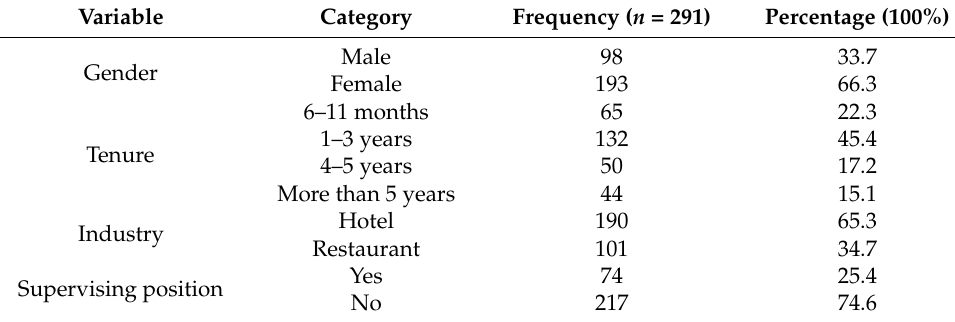
Table 1. Demographic profiles of the respondents ( n =